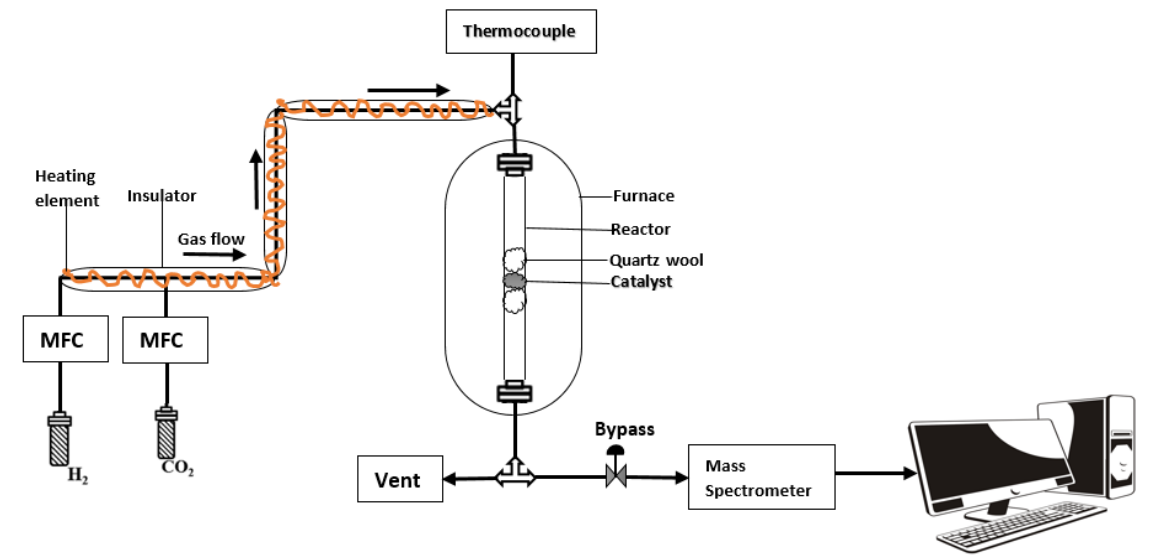
Figure 6. Diagram of RWGS reaction setup for catalytic activity test.